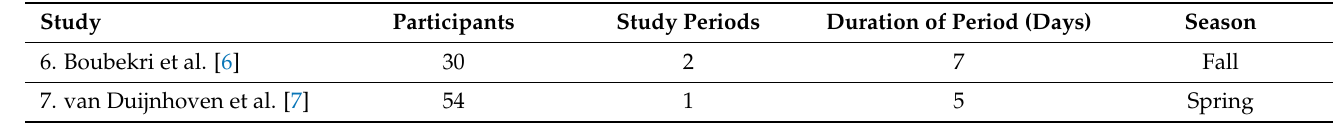
Table 2. Office field studies investigating occupant response to changes in daylight access. The studies either compared seasonal variations or compared adjustments to daylighting conditions. All of the studies were located in the Northern Hemisphere and published in 2010 or